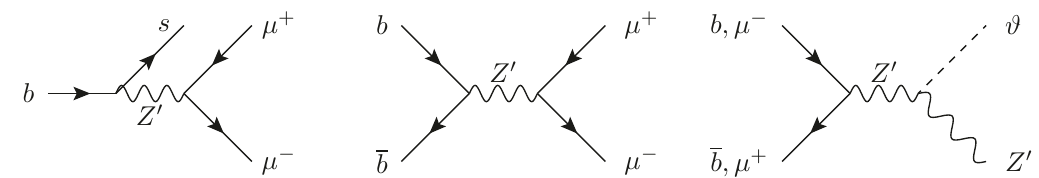
Figure 1. Feynman diagram of (left panel) Z 0 mediated contribution to b → sµ + µ − , (middle panel) the dominant LHC Z 0 production process, followed by subsequent decay into a di-muon pair µ + µ − and (right panel) flavonstrahlung at a hadron collider [ b ¯ b initial state] or a muon collider [ µ + µ − initial